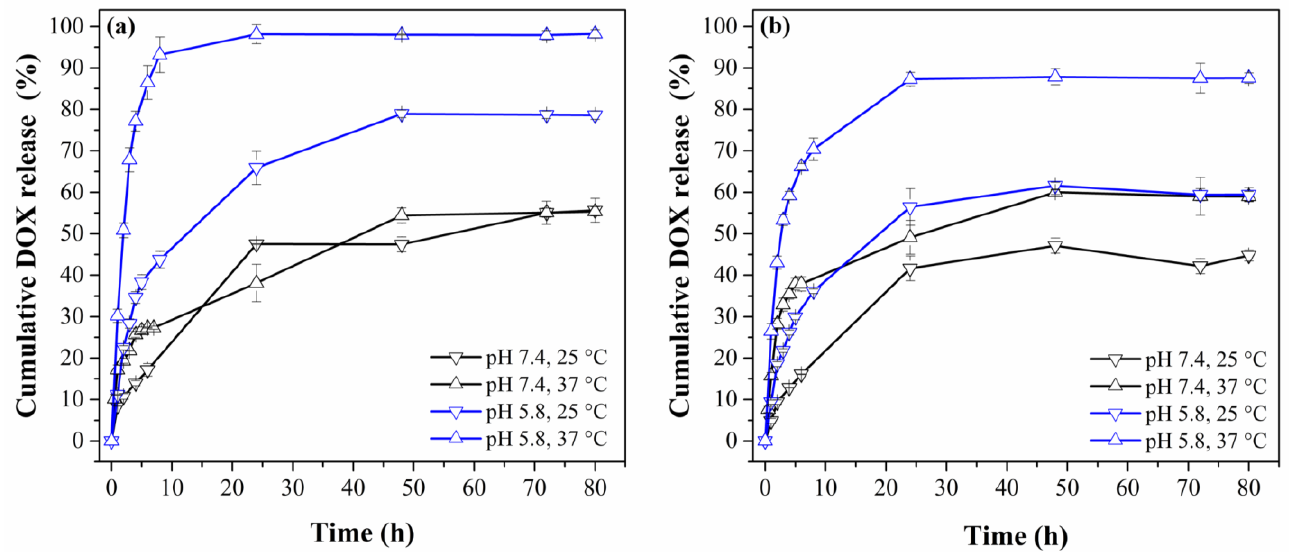
Figure 10. Cumulative DOX release profiles of MNPsFe 3 O 4 -SiO 2 -poly (NVCL-co-MAA) nanocom- posites with 33% ( a ) and 45% ( b ) grafting. Table 1. Comparison of DOX loading and DOX release of hybrid magnetic nanocomposites re- ported by other research groups.